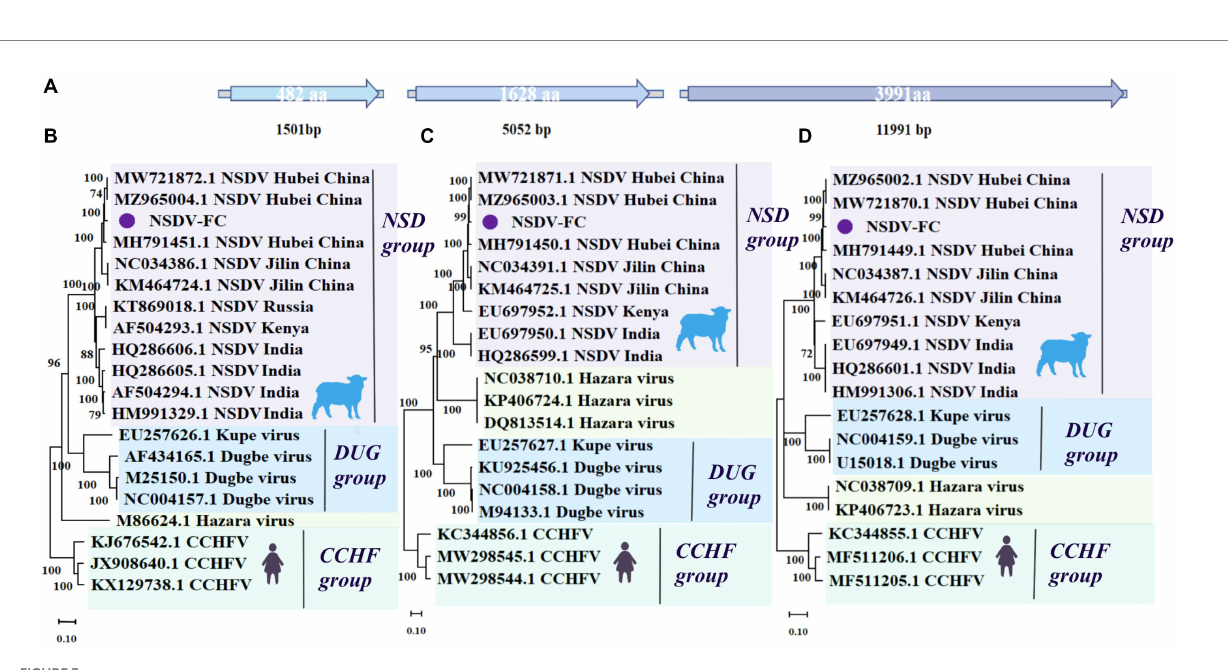
FIGURE 3 Genome structure and phylogenetic analysis of NSDV-FC. (A) Genomic structure of NSDV-FC. (B) Phylogenetic trees of NSDV-FC (1,501 bp) based on S segment of members within Nairoviridae. (C) Phylogenetic trees of NSDV-FC (5,052 bp) based on M segment of members within Nairoviridae. (D) Phylogenetic trees of NSDV-FC (11,991 bp) based on L segment of members within Nairoviridae. Nodes with bootstrap values >70 are noted. Scale bars indicate substitutions per site. Animal icons represent host species. Purple circles-marked strains were found in this